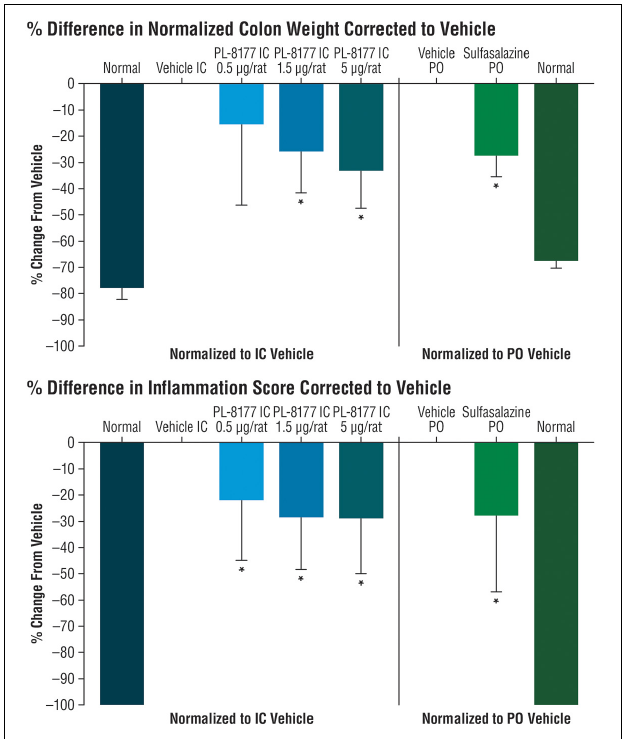
FIGURE 2 | Effects of PL-8177 and sulfasalazine on colon weight and inflammation scores in rats with DNBS-induced bowel inflammation. ∗ P < 0.05; DNBS, dinitrobenzene sulfonic acid; IC, intracolonic; PO, per oral.